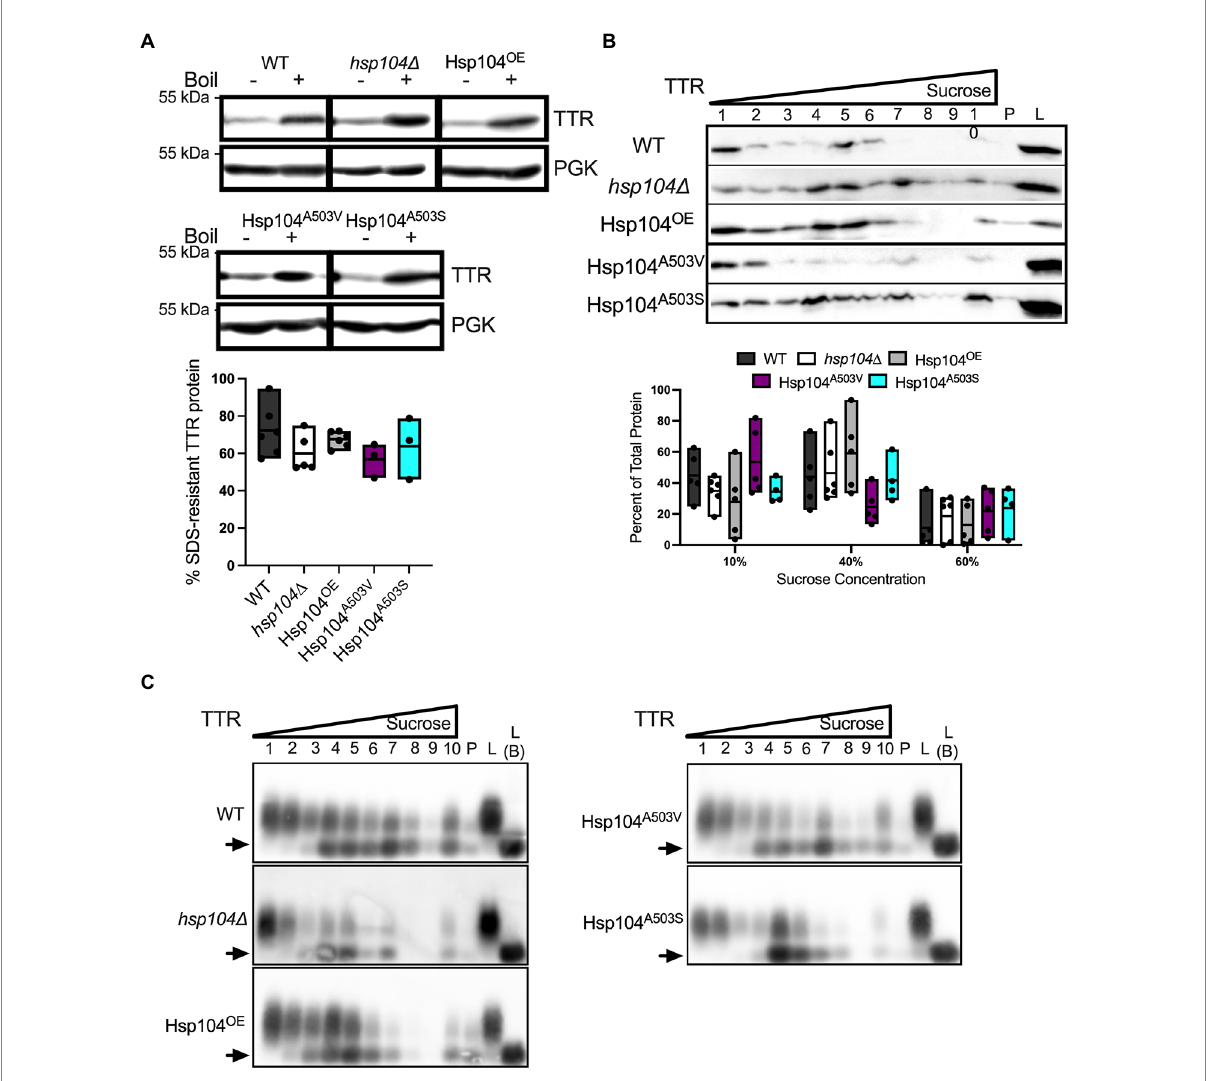
FIGURE 5 The effect of Hsp104 on aggregating TTR is muted in saturated cultures. All cultures were grown to saturation (OD 600 ≥ 2.0) over 48 h. (A) (Top) Representative blots from lysates were incubated at room temperature ( − ) or boiled (+). (Bottom) Quantification of SDS-resistant aggregated protein. Quantification is from at least 3 independent trials. Data is shown as means and ranges. (B) Lysates subjected to discontinuous sucrose gradient centrifugation and detected with anti-TTR antibody. (Top) Representative blots of TTR sedimentation. (Bottom) Quantification of sedimented TTR signal. All quantification represents 4–6 independent cultures per strain. Data is shown as means and ranges. (C) Sucrose gradient fractions of indicated strains from saturated cultures were resolved by SDD-AGE and visualized with anti-TTR. Note that L (B) indicates crude lysate that were boiled prior to loading. Arrows denote TTR monomers. Representative images are